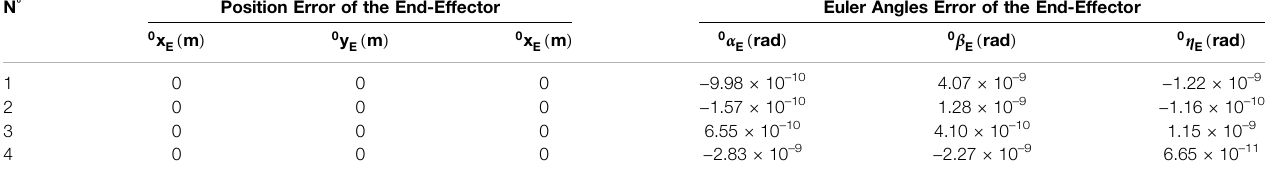
TABLE 5 | Position and directional angle errors of the end-effector. N ° Position Error of the End-Effector Euler Angles Error of the